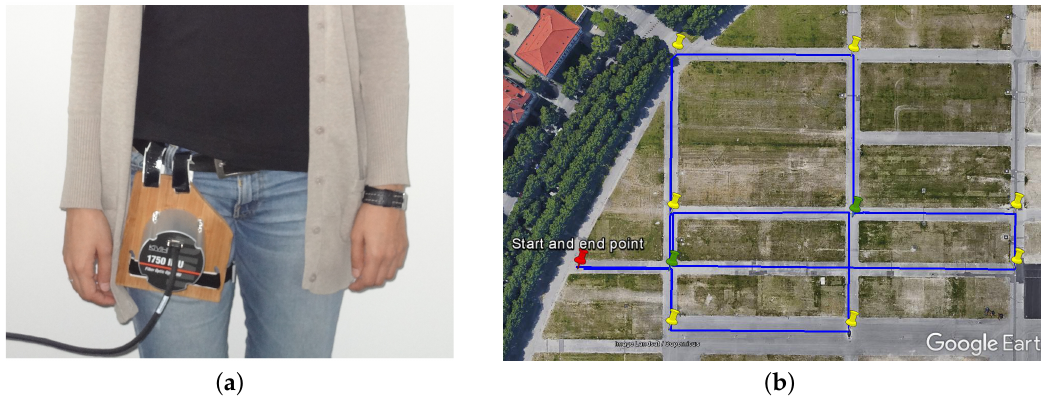
Figure 8. ( a ) IMU DSP-1750 test set up. ( b ) trajectory of the experiment represented with a blue line. The pins highlight the corners described during the